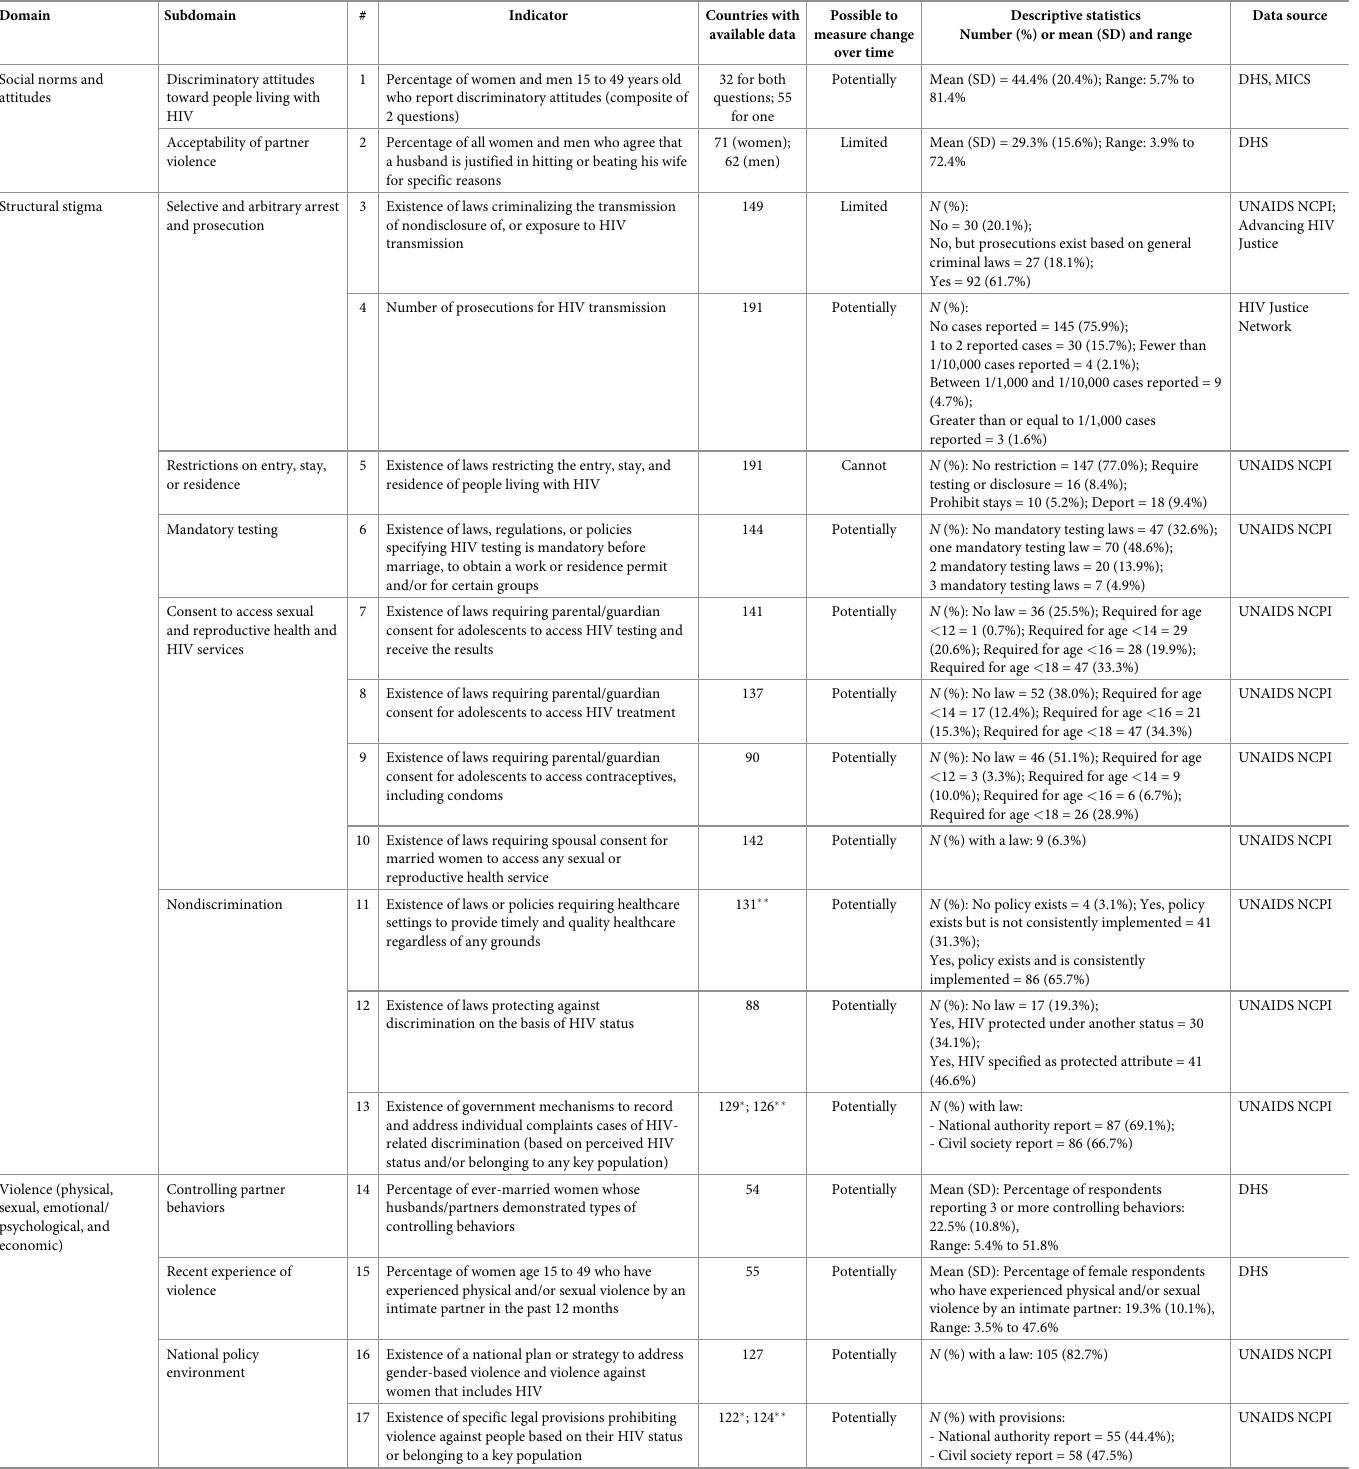
Table 2. Final indicators for HIV stigma.